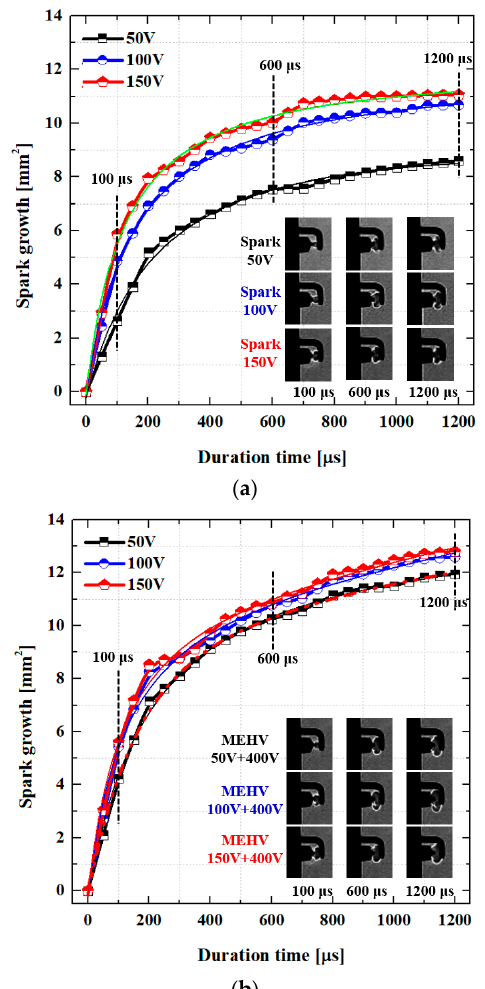
Figure 10. Result of spark growth compared with two different plasma energies (conventional spark and MEHV): ( a ) Conventional spark growth; ( b ) MEHV spark growth.